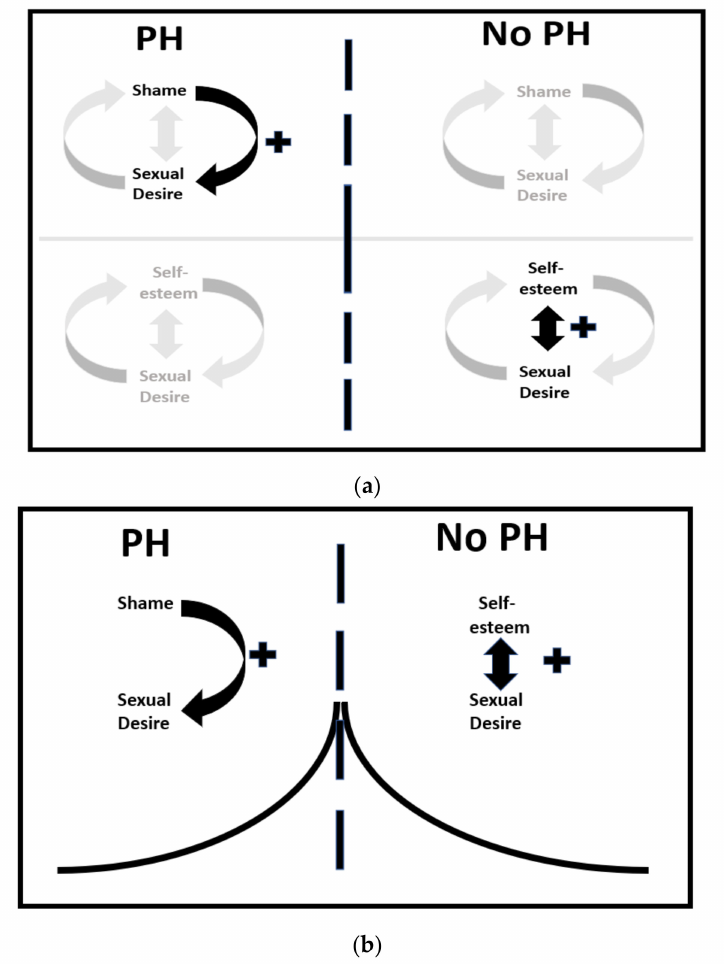
Figure 5. ( a ) Overview of exploratory models that were tested in this study. Significant models are highlighted and transposed to ( b ) to construct the Split Pleasure/Shame model. Lagged shame positively forecasted current sexual desire for PH (upper left) and there was a positive contempora- neous association between self-esteem and sexual desire for No PH groups (lower right). ( b ). The Split Pleasure/Shame model of emotion regulation for individuals with and without PH. PH is characterized by lagged shame positively forecasting sexual desire. Populations without PH are characterized by positive contemporaneous associations between self-esteem and sexual desire. The vertical dashed line represents the split between PH and No PH. The two bended lines that meet in the middle of the figure represent the continuum between PH and No PH with regard to the aforementioned associations. The meeting point of the two lines in the middle we hypothetically proffer as a tipping point that splits PH from No